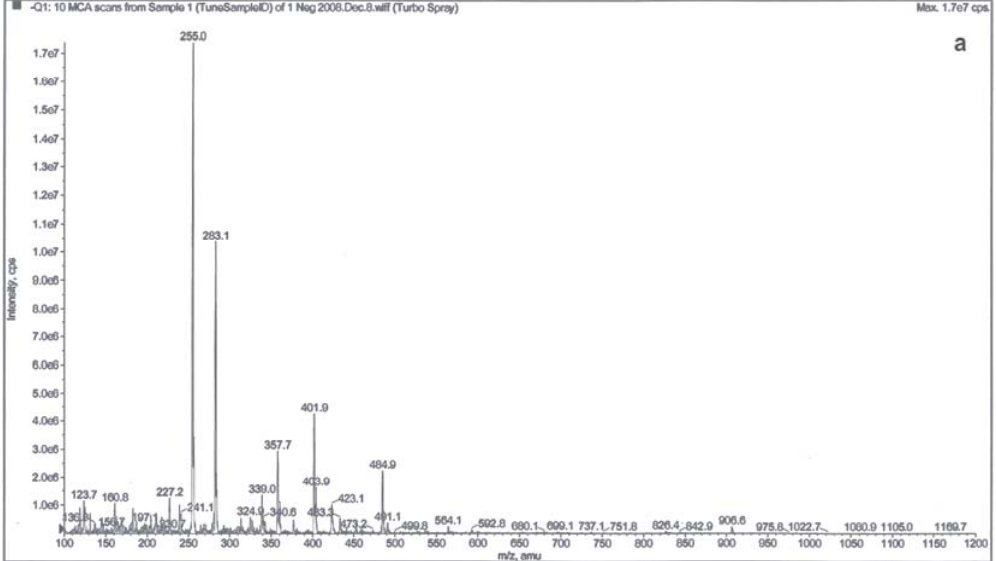
Figure 2. ESI mass spectra in the negative ion mode [M-H] - of 1 μ g/mL standard ochratoxin A (a) and the pulp extracts from good (b) and diseased (c) longan